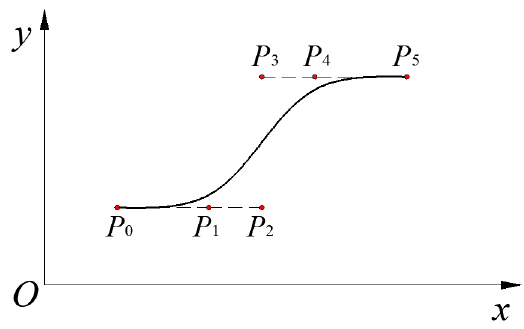
Figure 14. Schematic diagram of quintic Bézier curve.